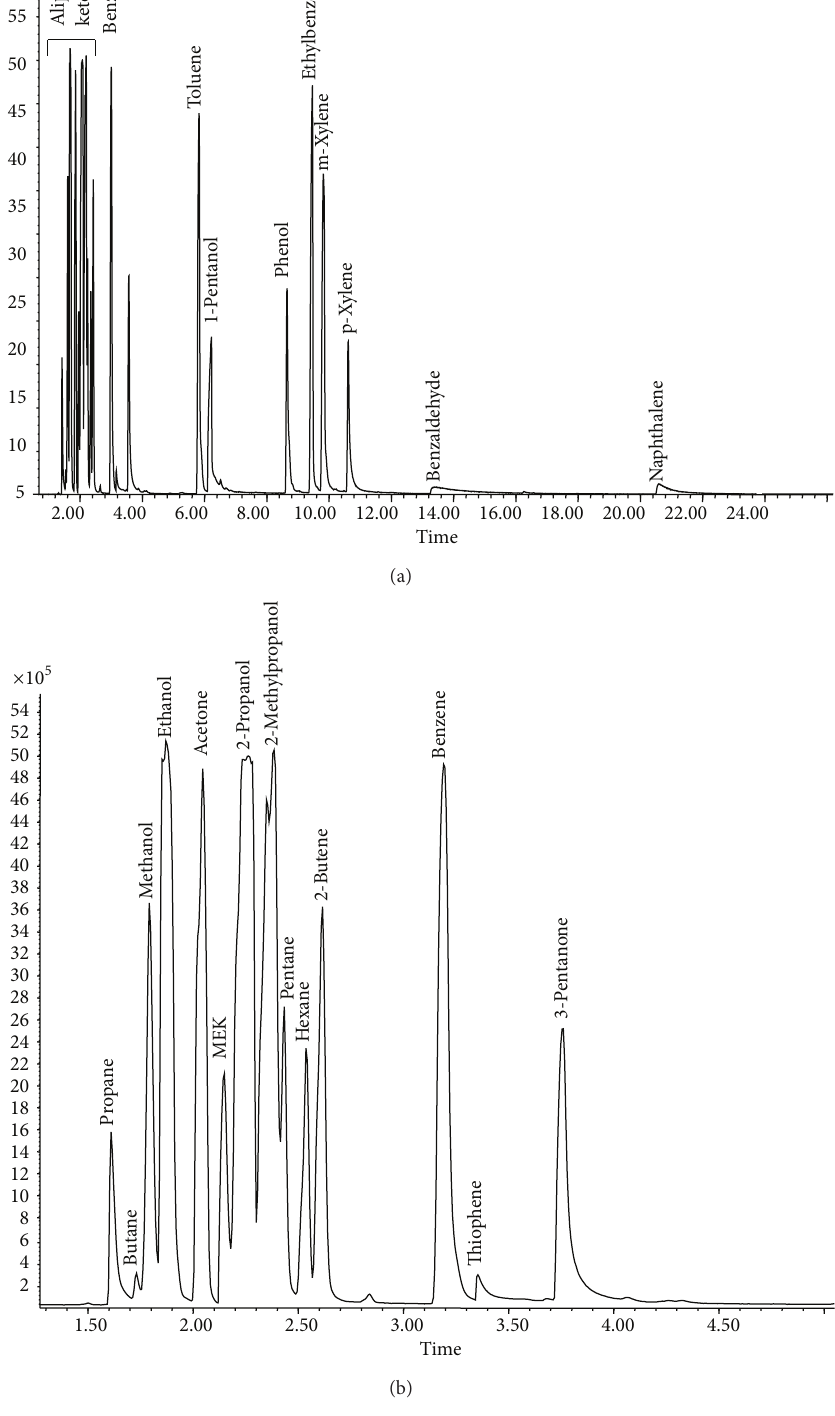
Figure 5: (a) GC-MS chromatogram of the condensate (trap b) coming from the devolatilization of the South Africa coal at 600 ∘ C. (b) Particularity of the light ends in the GC-MS chromatogram of the condensate (trap b) coming from the devolatilization of the South Africa coal at 600 ∘